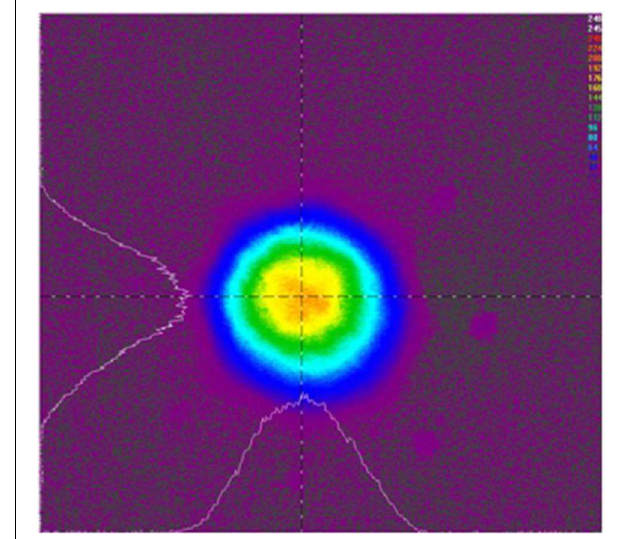
FIGURE 7 | False color image of delivered beam profile for the NCF at 1030nm (6 ps pulse) [50].